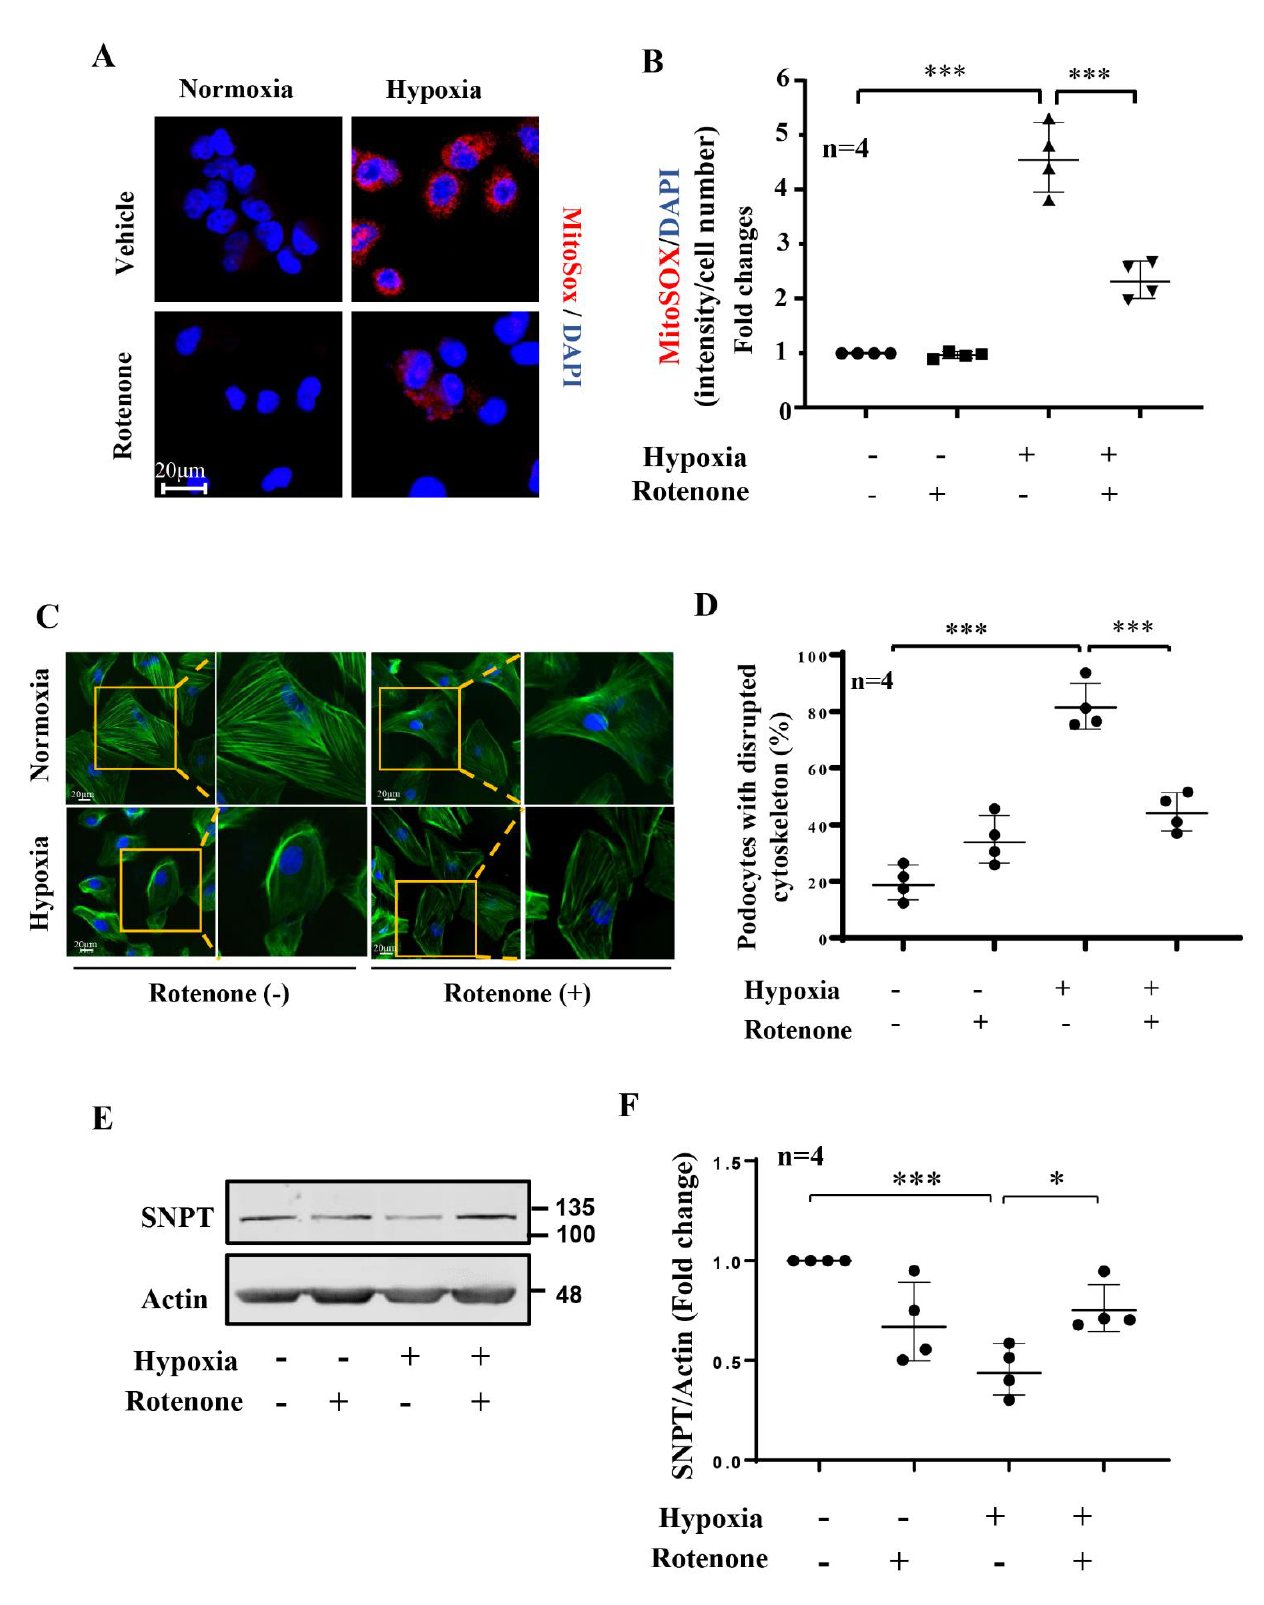
Figure 5. Role of mitochondrial ROS on hypoxia-induced podocyte injury. The cells were pre- treated with or without rotenone (2 µ mol/L) for 1 h and then incubated under normoxia or hypoxia (2% O 2 ) conditions for 24 h. ( A ). Representative images show MitoSOX staining in human podocytes under different conditions. Nucleoli were stained with DAPI (blue). ( B ). Quantification of